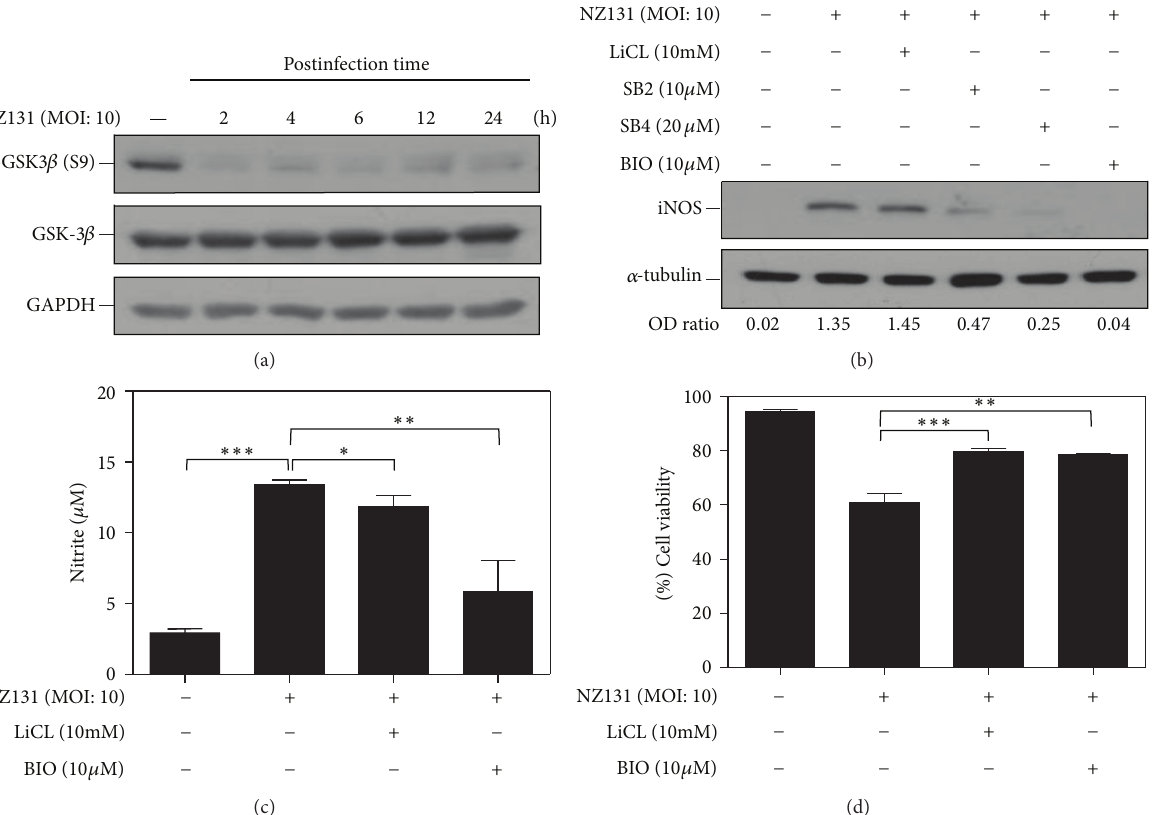
Figure 2: GSK-3 𝛽 is activated in macrophages after stimulation by NZ131 and inhibiting GSK-3 𝛽 reduces iNOS expression and NO production. (a) Western blot analysis was used to detect the expression of phospho-GSK-3 𝛽 at Ser9 in RAW 264.7 cells (MOI: 10) at the indicated time points. (b) After pretreatment with various GSK-3 𝛽 inhibitors (LiCl, SB216763, SB415286, and BIO), Western blot analysis was used to determine the expression of iNOS in RAW 264.7 cells at 6 h after NZ131 infection. (c) After NZ131 stimulation (24 h, MOI: 10), Griess reagent was used to determine the NO production in RAW 264.7 cells pretreated with GSK-3 𝛽 inhibitors (LiCl and BIO). (d) Percentage of cell viability was determined 24 h after NZ131 infection with or without concomitant treatment with GSK-3 𝛽 inhibitors (LiCl and BIO). The data are means ± SD of the results obtained from three individual experiments. ∗ 𝑃 < 0.05 , ∗∗ 𝑃 < 0.01 ; ∗∗∗ 𝑃 < 0.001 , comparisons between the indicated